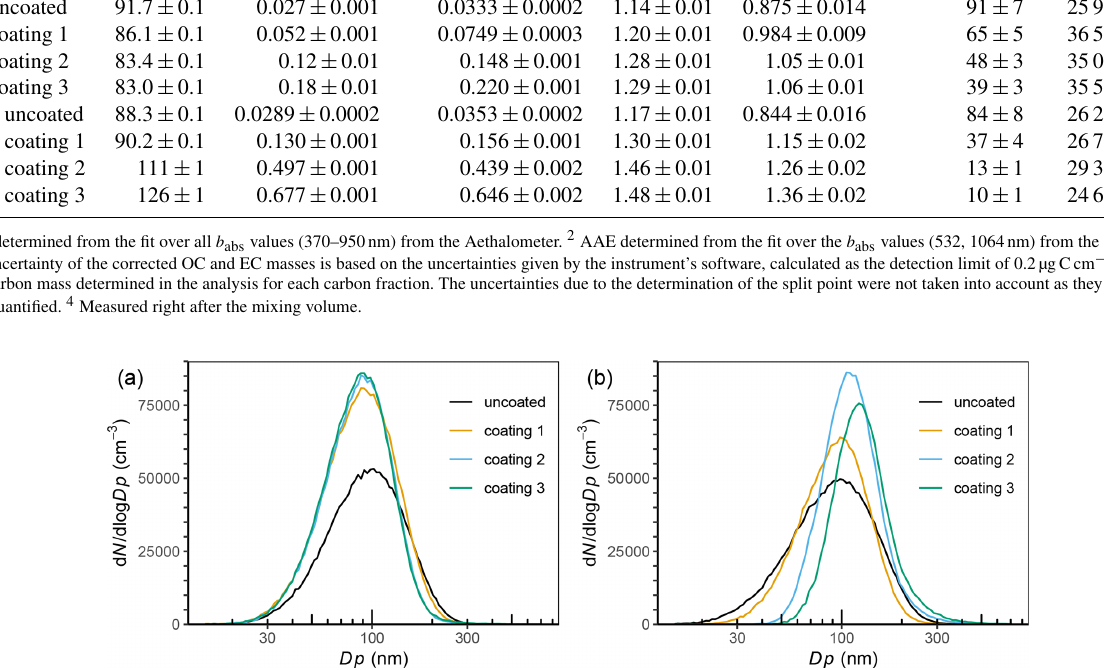
played in Fig. 3a (main and secondary y axis, respectively), while GMD mob is shown as a label on the data